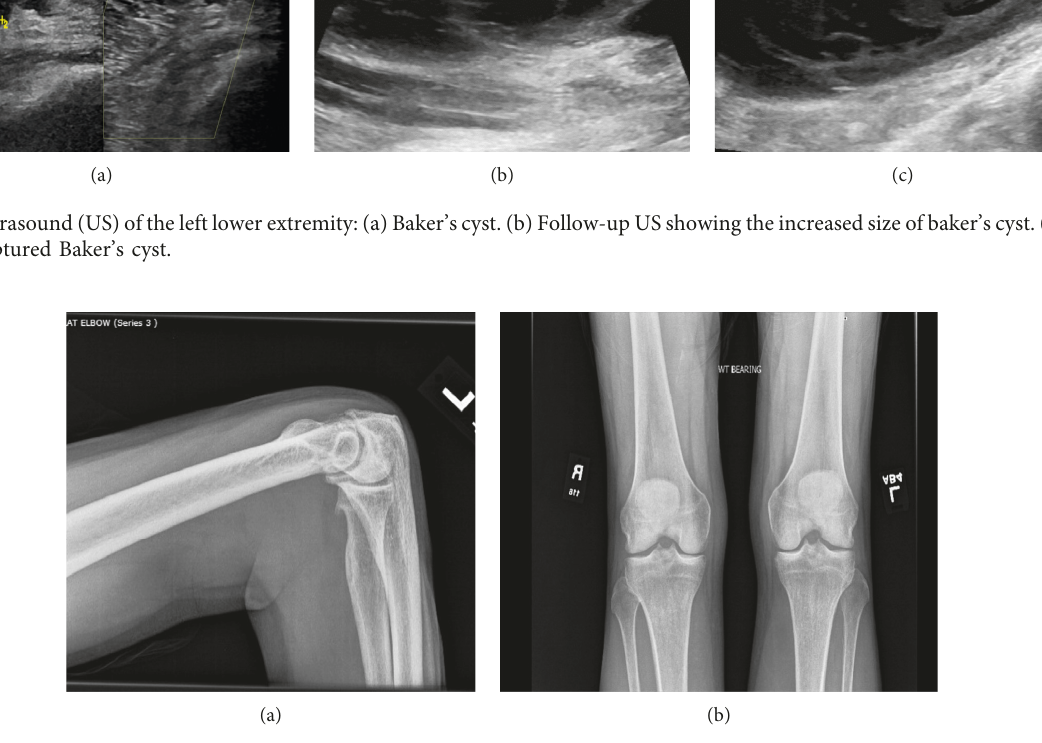
Figure 2: X-ray of the left elbow joint and bilateral knee joints. (a) Moderate osteophytosis at the humeroulnar articulation and involving the radial head with mild joint space narrowing and no joint effusion. (b) Anterior-posterior weight-bearing view; no acute fracture/ dislocation, and joint spaces grossly preserved. Table 1: Immunologic